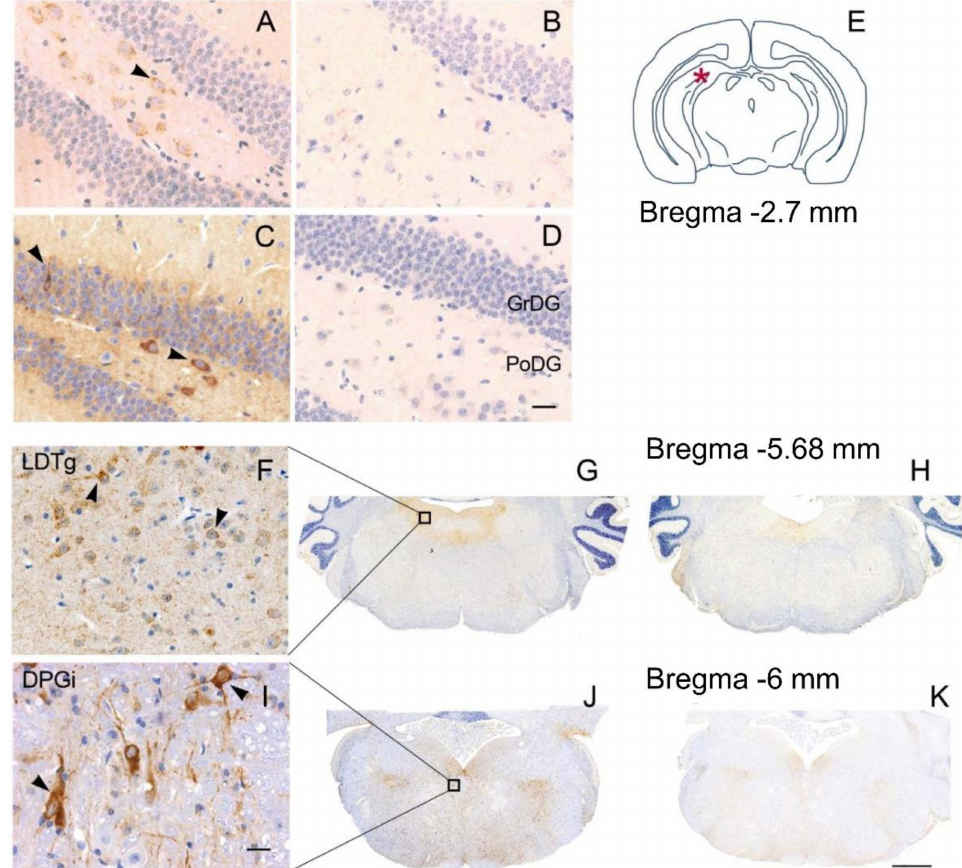
Figure 2. Representative sections from hippocampus ( A – D ) and brainstem ( F – K ) of wild type mice ( A , B , F – H ) and female hTau mice ( C , D , I – K ) infused with IgG from a patient with anti-IgLON5 disease ( A , C , F , G , I , J ) or from a control subject ( B , D , H , K ). The asterisk in ( E ) indicates the area of analysis of the phosphorylated Tau protein deposition in the hippocampus at the reported bregma coordinate. ( F , I ) are magnifications of the areas indicated by the squares in ( G , J ), respectively. The pathology appeared more severe in hTau than in wild-type mice. Scale bars: ( D , I ) = 20 µ m; ( K ) = 500 µ m. PoDG: polymorph layer of the dentate gyrus; GrDG: granule cell layer of the dentate gyrus; LDTg: laterodorsal tegmental nucleus; DPGi: dorsal paragigantocellular